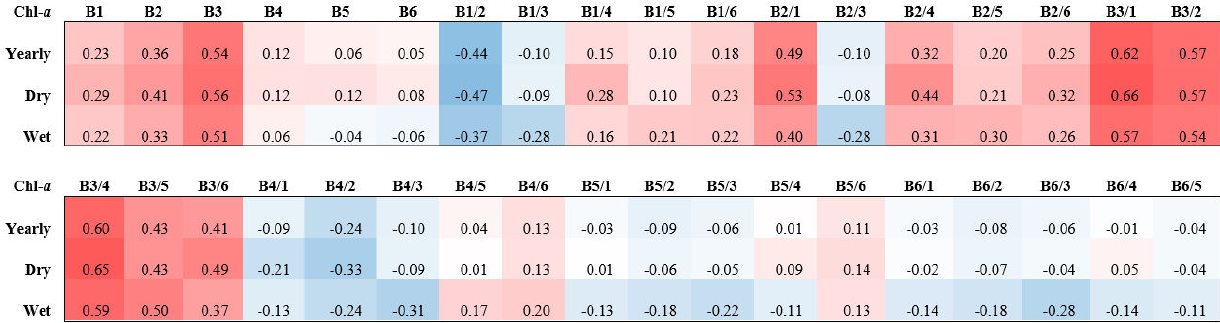
Figure 3. Correlation matrix of Chl- a and Himawari-8 bands. Features that are highly correlated to Chl- a are shown in dark red and dark blue colours such as band ratios of Band 3 and Band 1/2.